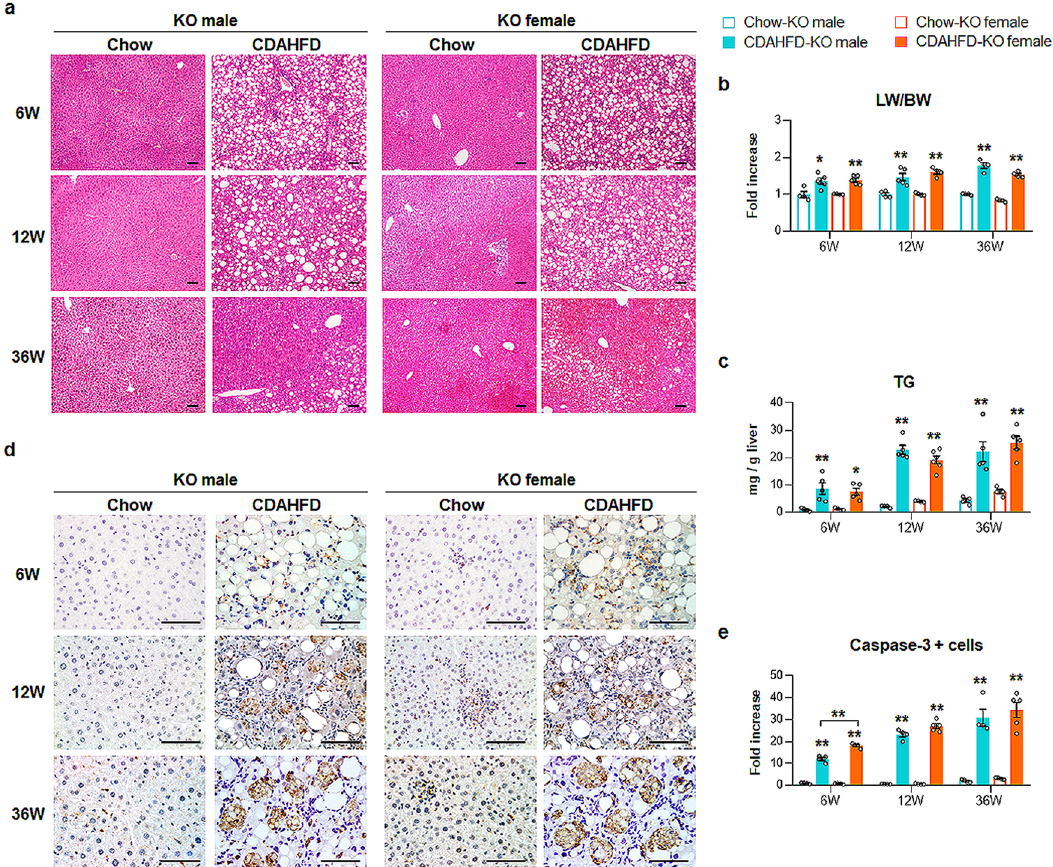
Fig. 4 Fpr2-depleted female mice are vulnerable to liver damage. a Representative images of H&E-stained liver sections from Fpr2-knockout (KO) male and female mice treated with chow or CDAHFD (Scale bar, 50 μ m). b LW/BW and c hepatic TG level of these mice. Data represent the mean ± S.E.M. ( n ≥ 4/group, * p < 0.05, ** p < 0.005 vs own control). d Immunohistochemical staining for active Caspase-3 in liver sections from representative mice from each group (Scale bar, 50 μ m). e Quantitative active Caspase-3-stained data from these mice. Caspase-3-positive cells were quanti fi ed by counting the total number of Caspase-3-positive cells per fi eld and dividing by the total number of hepatocytes per fi eld. Data represent the mean ± S.E.M. ( n ≥